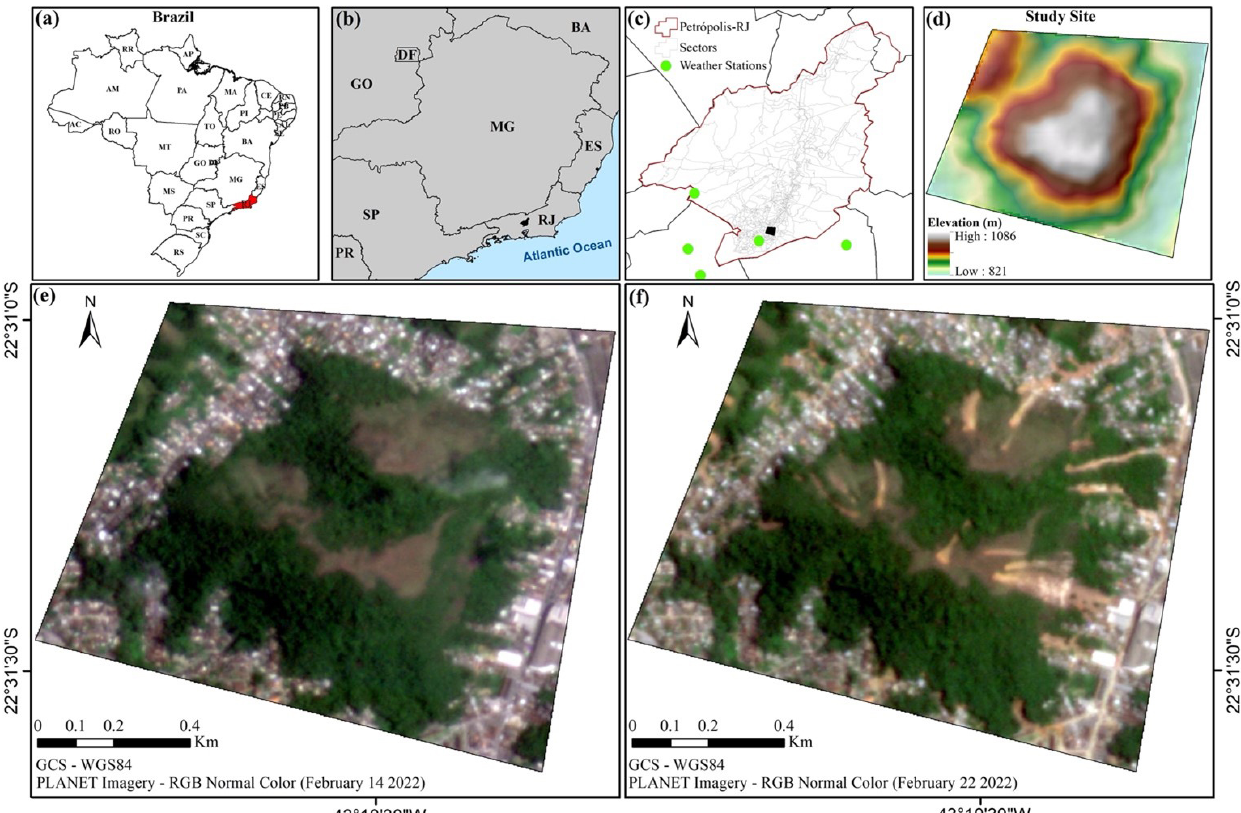
Figure 1. Petrópolis and the study site. (a) Location of the state of Rio de Janeiro in Brazil, (b) location of the study site in the state of Rio de Janeiro. Panels (a) – (b) were based on the Brazilian Institute of Geography and Statistics (IBGE). (c) Location of the study site in the city of Petrópolis and the position of weather stations and (d) elevation map of the study site (ALOS PALSAR, https://asf.alaska.edu/data-sets/ sar-data-sets/alos-palsar/, last access: 10 May 2022). (e) Planet image natural color from 14 February 2022 and (f) Planet image natural color from 22 February